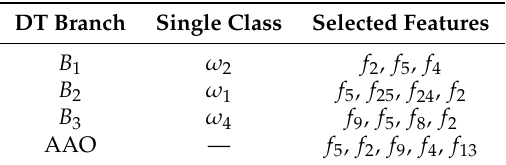
Table 3. Single classes and selected features for each branch of the numerically optimized DT for simulated test dataset